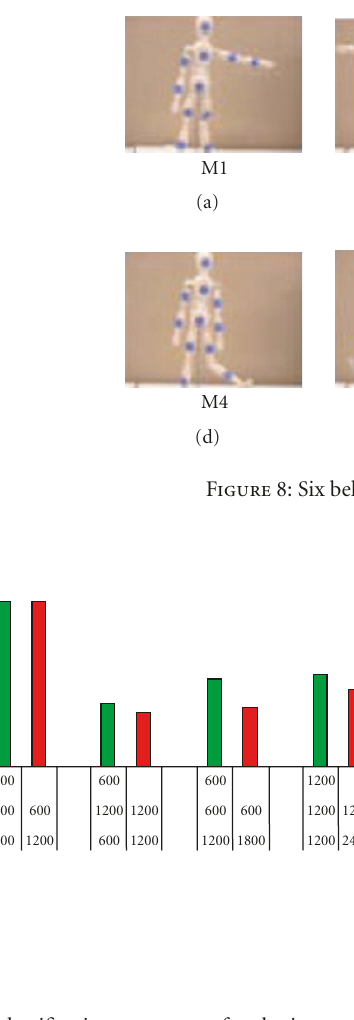
Figure 9: Overall misclassification error rates for the incremental and retrain models. Table 2: Experiment 5: misclassification error rates for selected ar- ticulated motions.